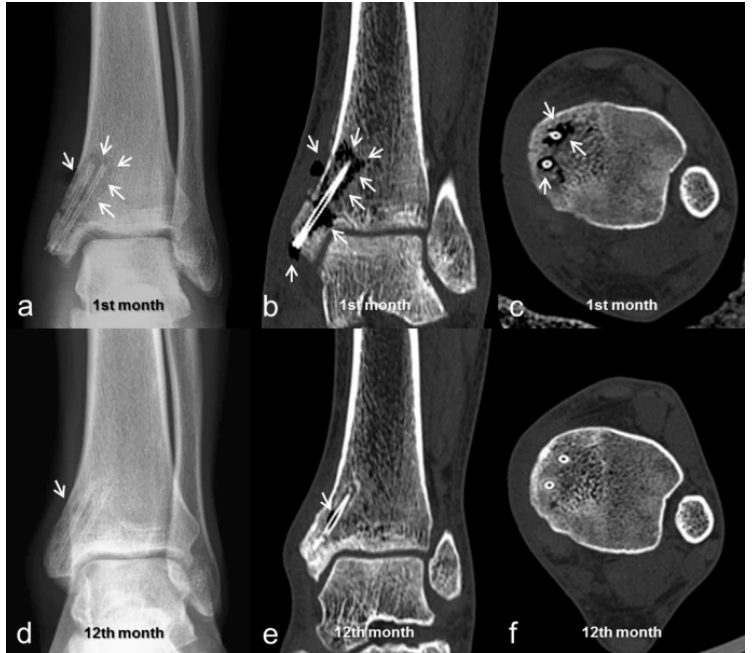
Figure 4. Isolated medial malleolar fracture treated with biodegradable magnesium screws (MAGNEZIX ® CS; Syntellix AG, Hanover, Germany). ( a – c ) taken 1 month after implantation; ( d – f ) on 12th month after implantation. ( a , d ) are radiographs; ( b , c , e , f ) are taken using CT. White arrows point at gas formation around implant. Reproduced from May et al. (2020) [15]. Copyright Springer Nature,